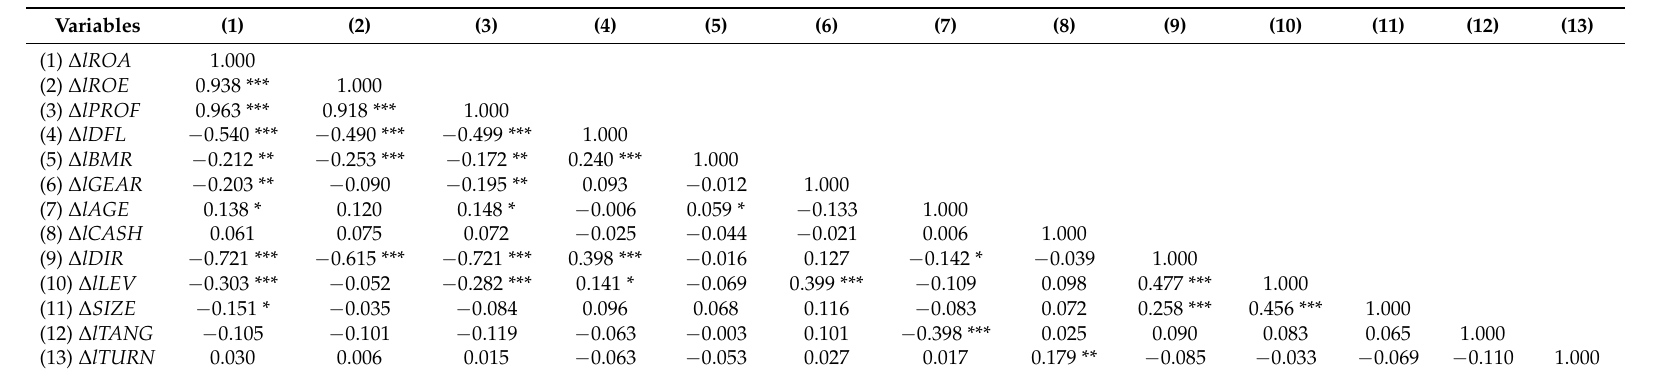
Table 2. Correlation